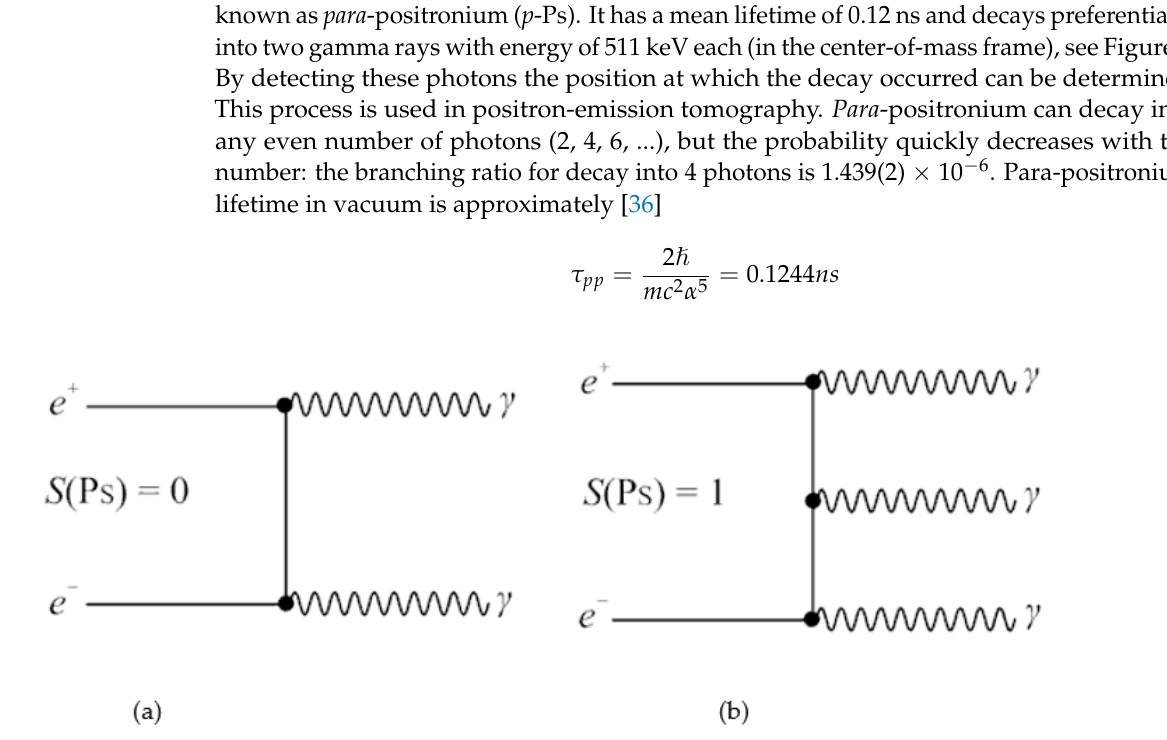
Figure 2. Diagrams of two annihilation processes of ( a ) para-positronium with a creation of two gamma-quants ( b ) Ortho -positronium with a creation of three gamma-quants.